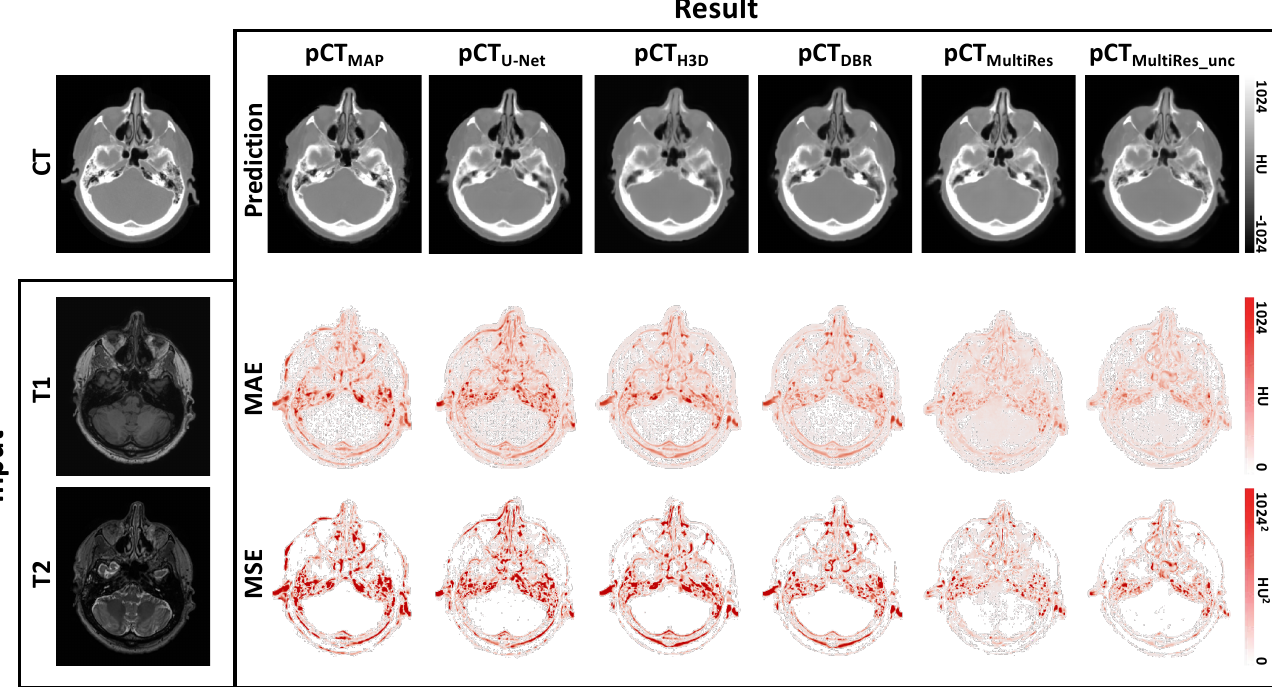
Figure 5. Ground truth CT and input T 1 − and T 2 − weighted MR images (first column) of the brain followed by predicted pseudo CT images with corresponding Mean Absolute Error (MAE) and Mean Squared Error (MSE) for a multi-atlas propagation method, 3D U-Net, HighRes3DNet, Deep Boosted Regression, MultiRes without uncertainty and MultiRes unc including uncertainty